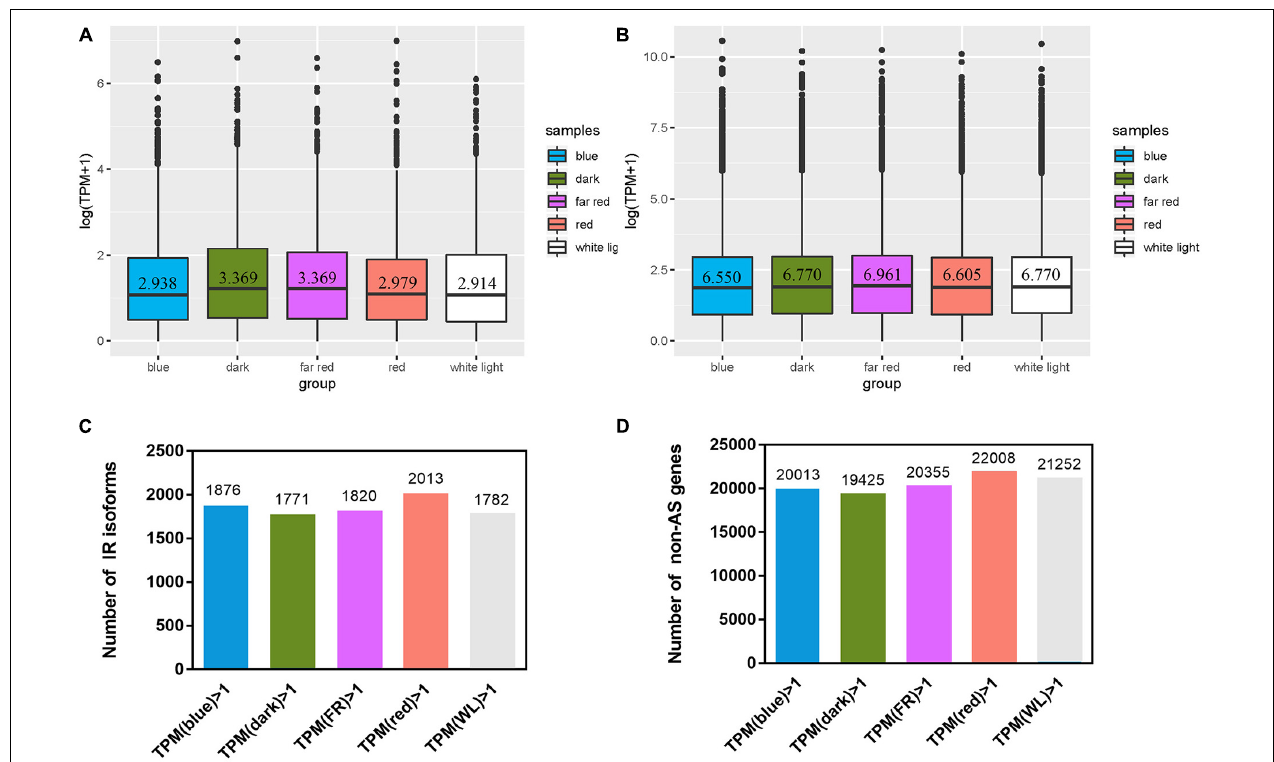
FIGURE 2 | Expression of intron retention (IR) isoforms and non-alternatively spliced (non-AS) genes after light treatment. Isoforms with a TPM > 1 were defined as expressed ones. (A,B) Box-plots using log (TPM + 1) as the ordinate show TPM distribution of expressed IR isoforms and non-AS genes under five treatments, respectively. (C,D) the number of expressed IR isoforms and non-AS genes,